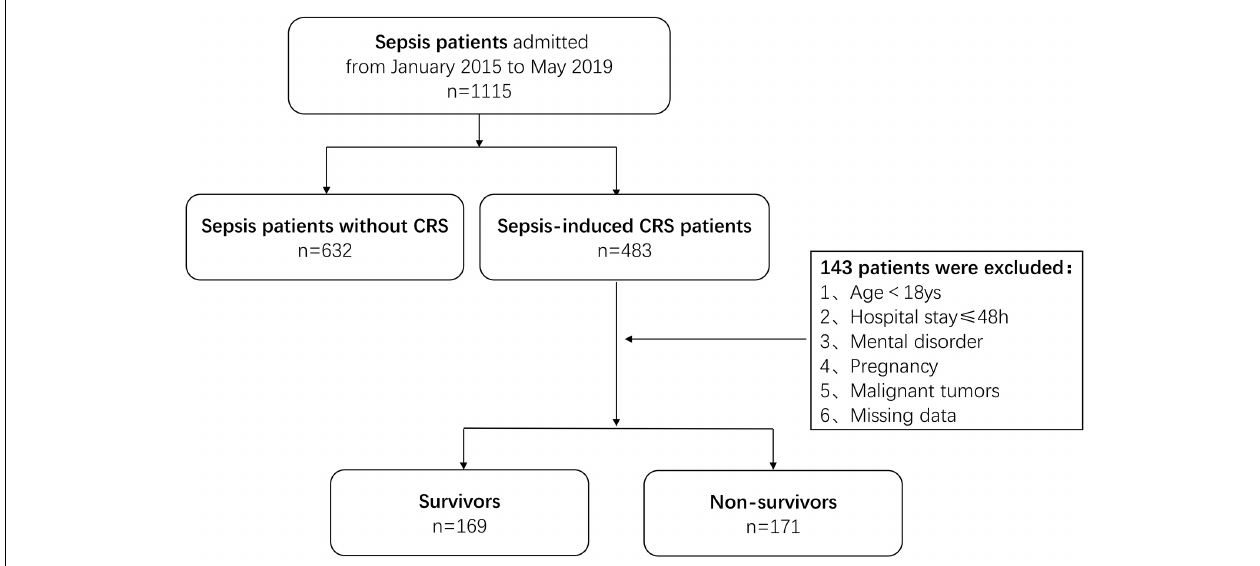
FIGURE 1 | Flow chart illustrating the patient enrollment in discovery cohort.